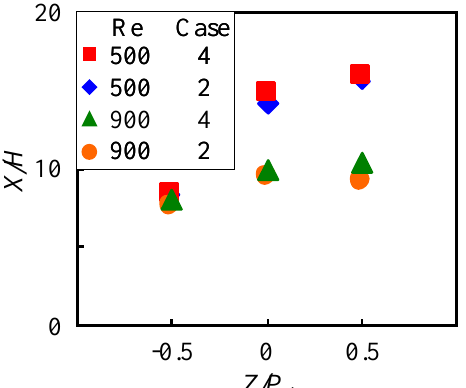
Fig. 14 Time-averaged reattachment point in the spanwise direction at case 2 and